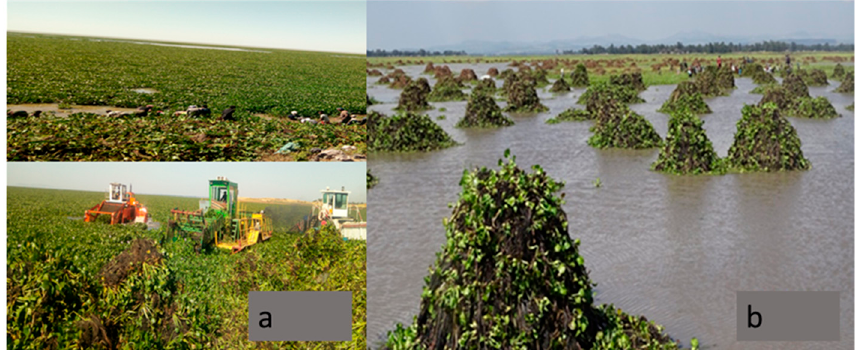
Figure 9. ( a ) Water hyacinth mechanical removal campaign in 2020; ( b ) water hyacinth collected from water to dry land (Source: Lake Tana Protection Agency, 2020).